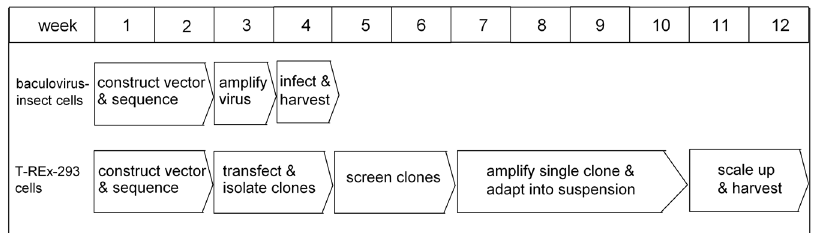
Figure 5. Timeframe for the establishment of the transient baculovirus-insect cells system and stable expression with inducible T- REx-293 system for GPCR expression.